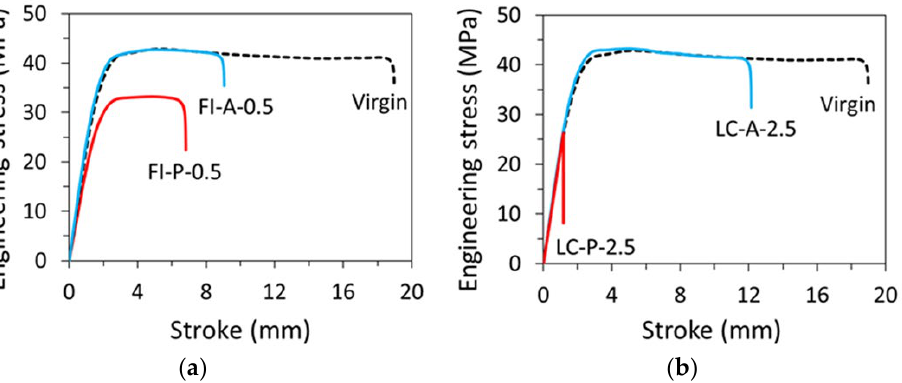
Figure 5. Engineering stress–stroke curves for pipe ring specimens: ( a ) after full immersion for 0.5 h in acetone (FI-A-0.5) or primer (FI-P-0.5) and then air dried for 10.5 days, and ( b ) after local contact